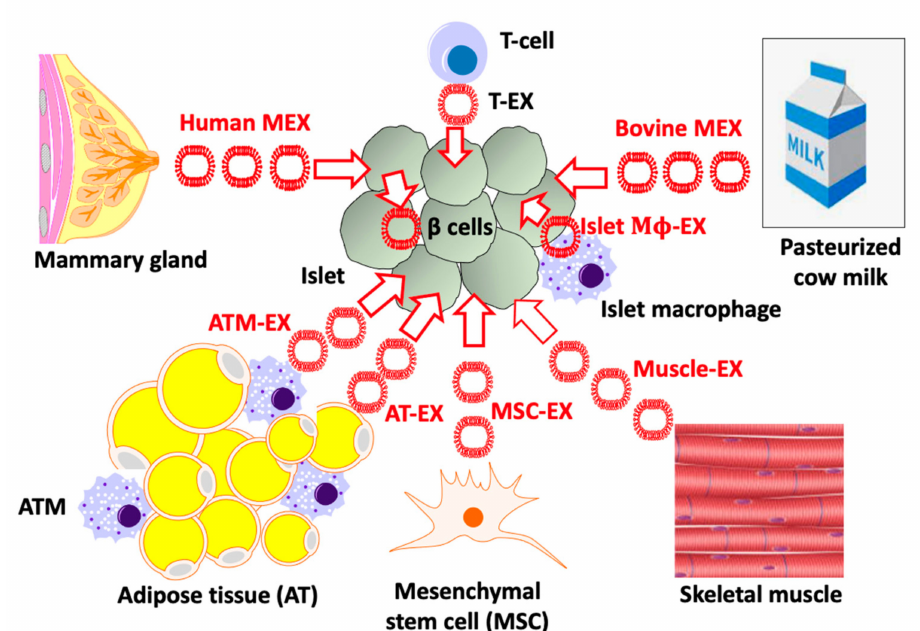
Figure 1. Illustration of exosome crosstalk to pancreatic β cells derived from various organs and exosome- emitting cells. Exosomes of human milk (MEX) during the postnatal breastfeeding period as well as bovine MEX derived from pasteurized cow milk may reach the islet cells of the milk recipient modifying β cell gene regulation. Abbreviations: AT = adipose tissue; ATM = adipose tissue macrophage; Islet M φ -EX = Islet macrophage-derived exosome; MEX = milk-derived exosome; MSC-EX = MSC-derived exosome; Muscle-EX = Skeletal muscle cell-derived exosome; T-EX = T cell-derived